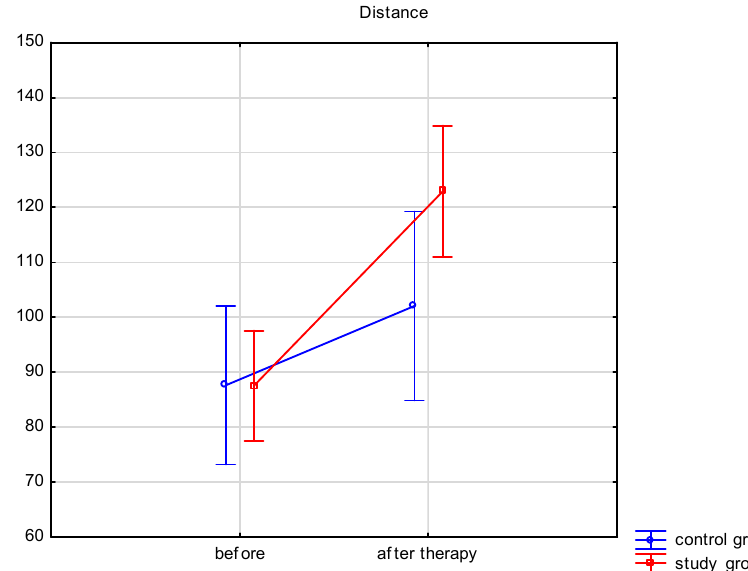
control group study groupbefore after